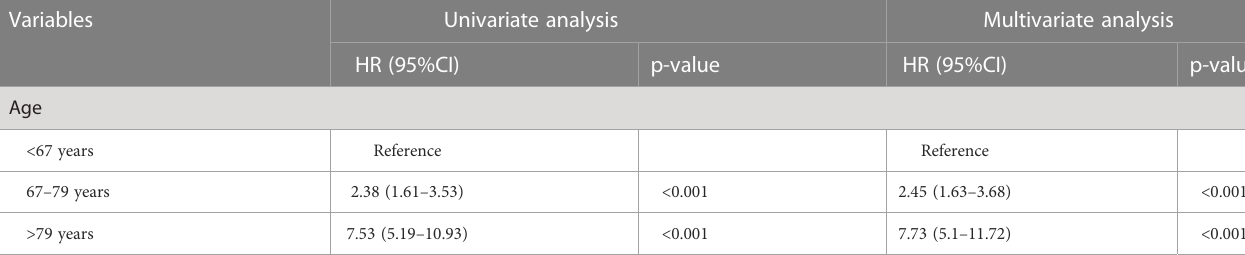
TABLE 2 Univariate and multivariate Cox analyses of overall survival for patients with